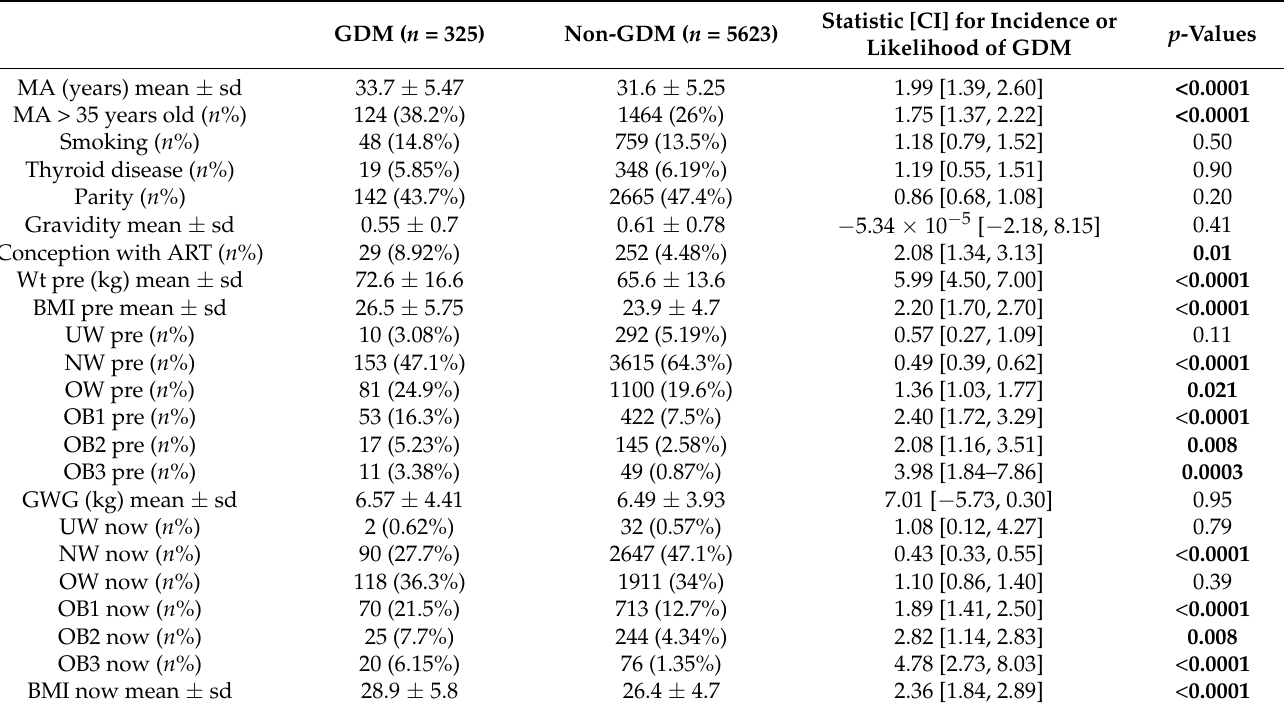
Table 1. Characteristics of the included population ( n =